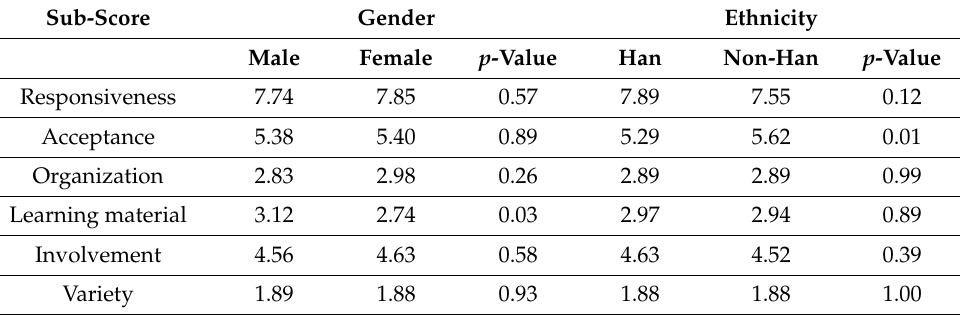
Table 5. HOME sub-scores by gender.